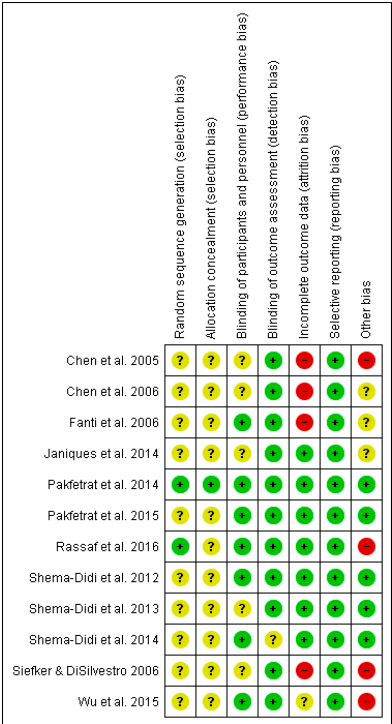
Figure 9. Risk of bias summary across the included studies. Unclear risk of bias: “?”, Low of risk of bias: “+”, High risk of bias: